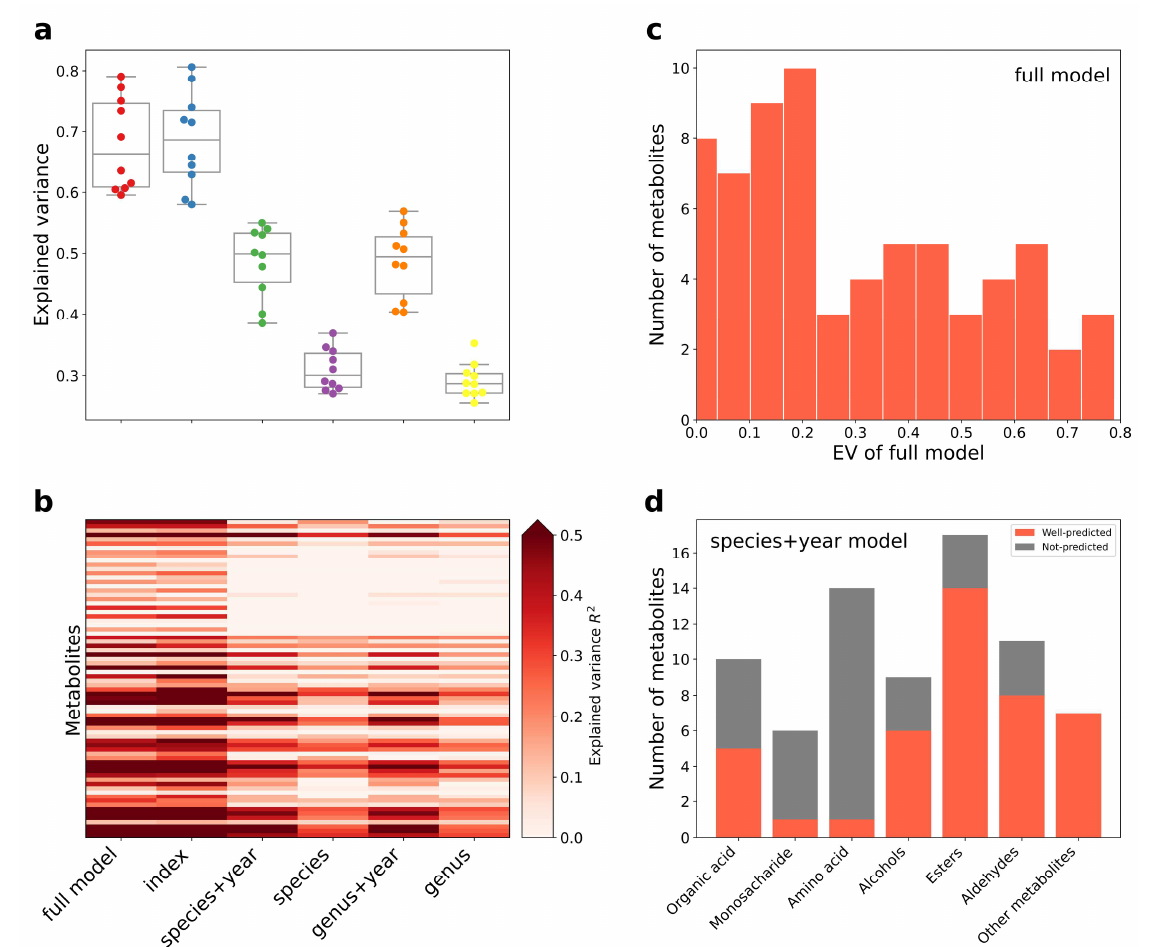
Figure 4. Model performance in feature groups. ( a ) Box and swarm plot of explained variance of top 10 well-predicted metabolites of each model. ( b ) Heatmap of explained variance for each metabolites of different models. ( c ) Distribution of explained variance of metabolites for FM model. ( d ) Prediction performance in different metabolite group.